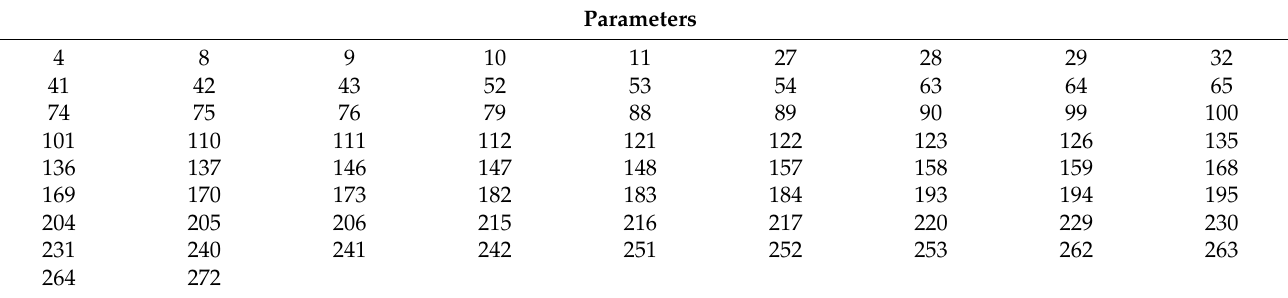
Table 2. Number of parameters used for the system according to Table A1.